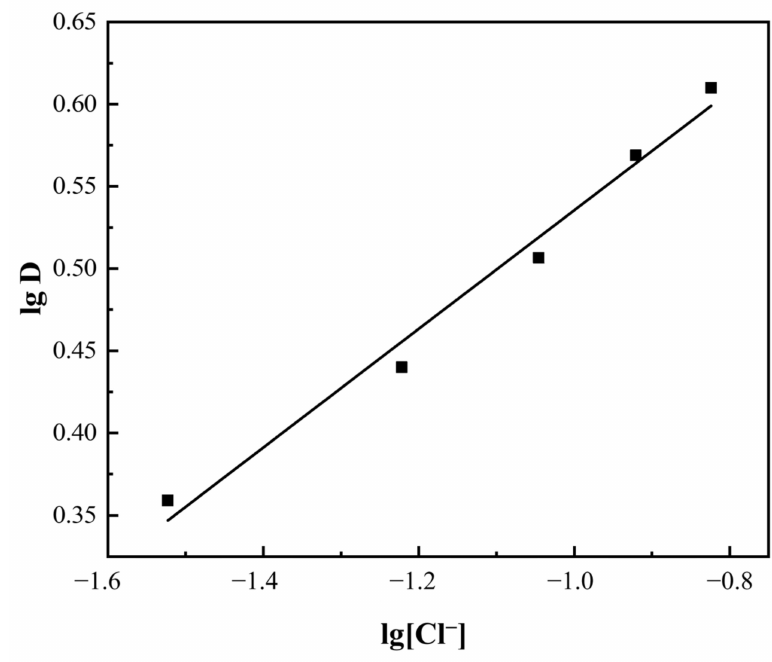
Figure 10. The relationship between the lg D of Y 3+ and lg [Cl −